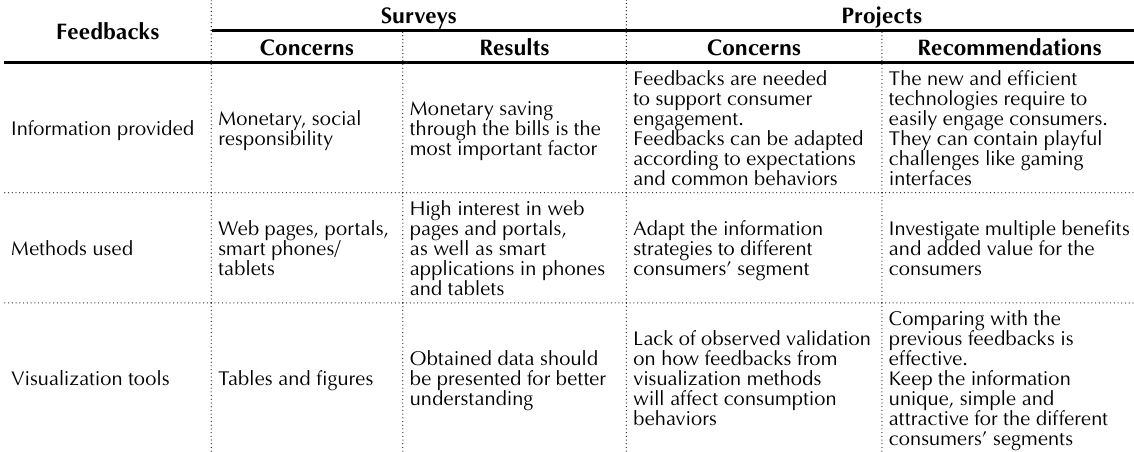
Table 3. Summary of findings from European surveys and projects on feedback